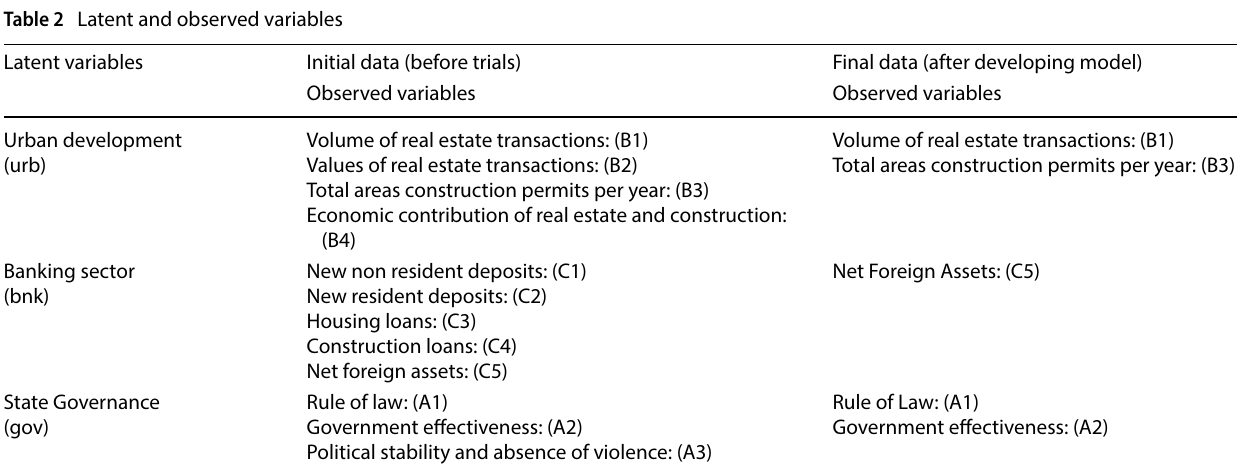
Table 2 Latent and observed